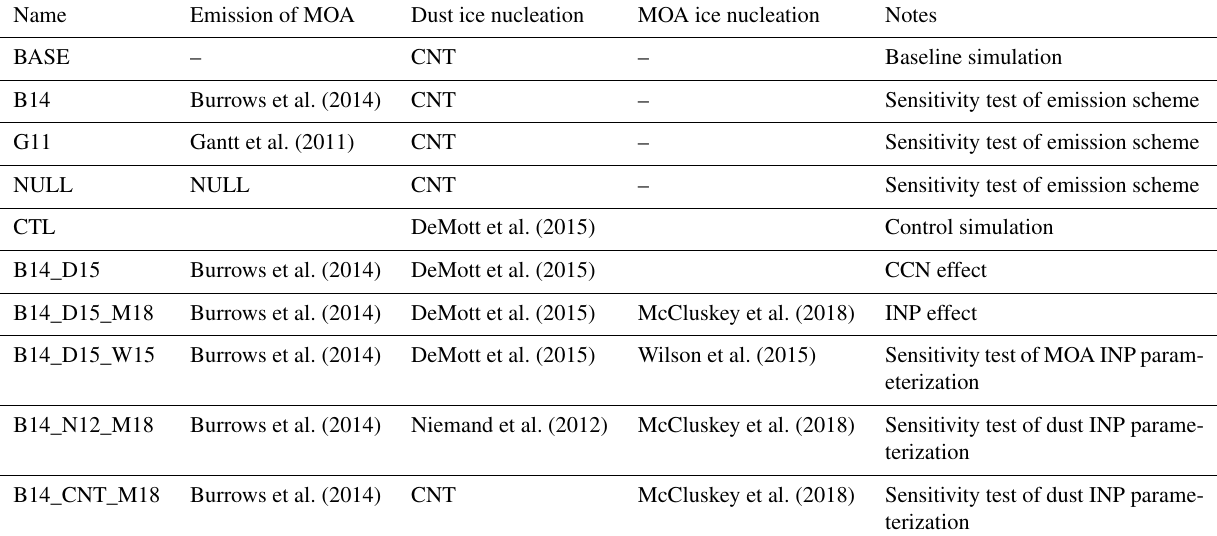
Table 4. List of experiments to test model sensitivity to different emission and ice nucleation schemes.